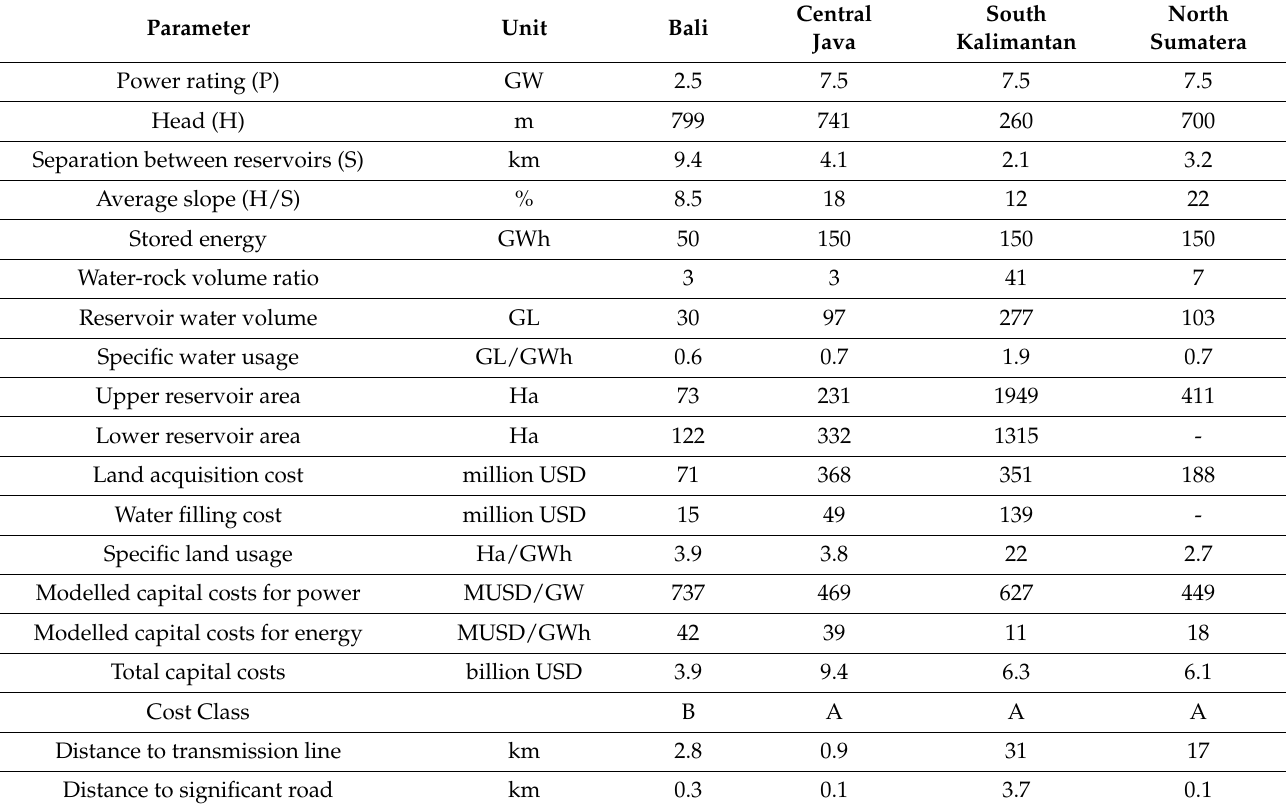
Table 6. Characteristics of four representative potential PHES